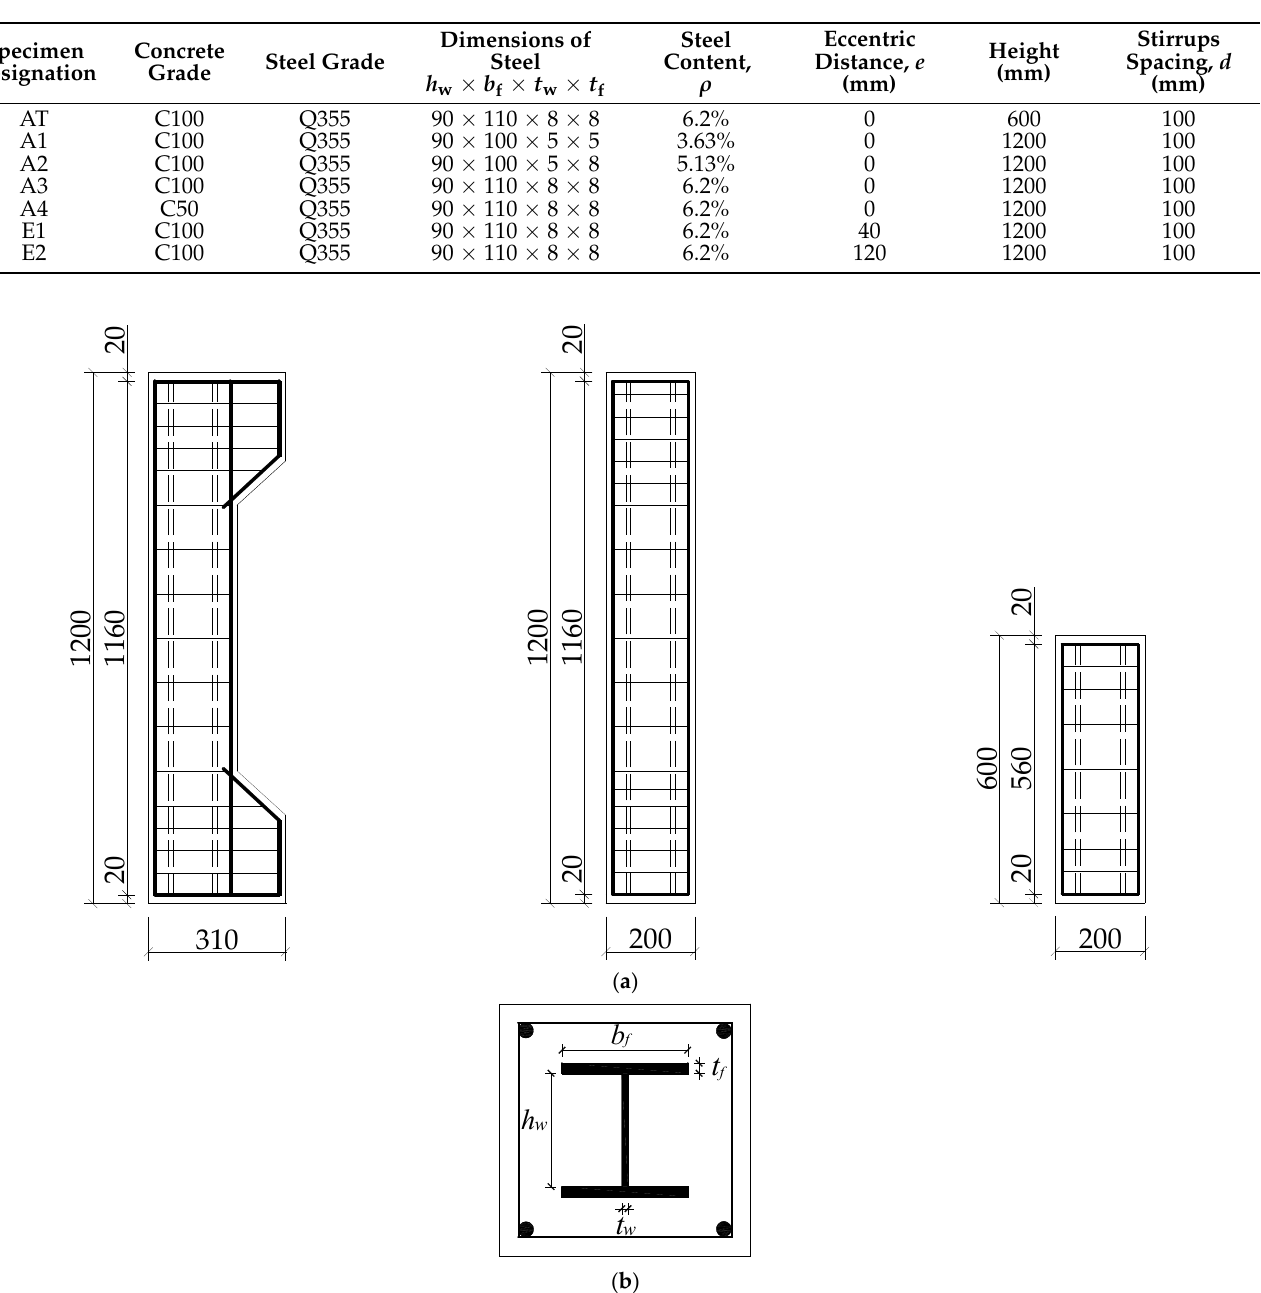
Table 1. The key parameters of the columns.